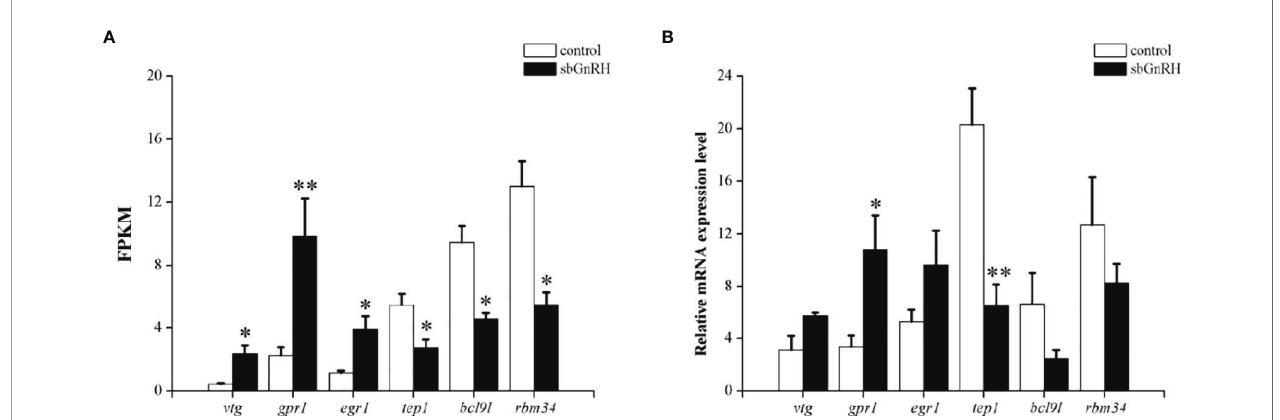
FIGURE 7 | Expression of the gene in the liver of pompano in control and sbGnRH injection groups. (A) Transcriptome data (n=3) and (B) quantitative polymerase chain reaction (qPCR) results (n=3). Data are presented as mean ± standard error (SEM). * and ** indicate statistical differences at P < 0.05 and P < 0.01, respectively. The statistical signi fi cance (compared with the control group) was calculated using one-way analysis of variance (ANOVA), followed by Duncan ’ s post hoc